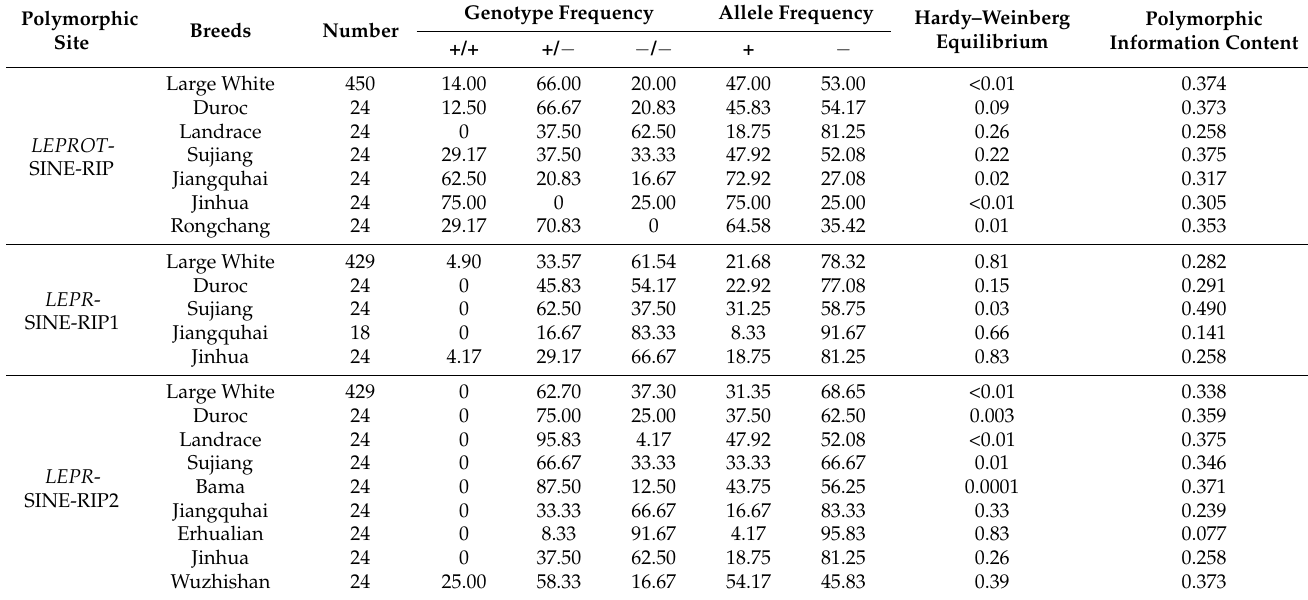
Table 2. Genotype and allele frequency of three RIPs in the RIP polymorphic breeds.